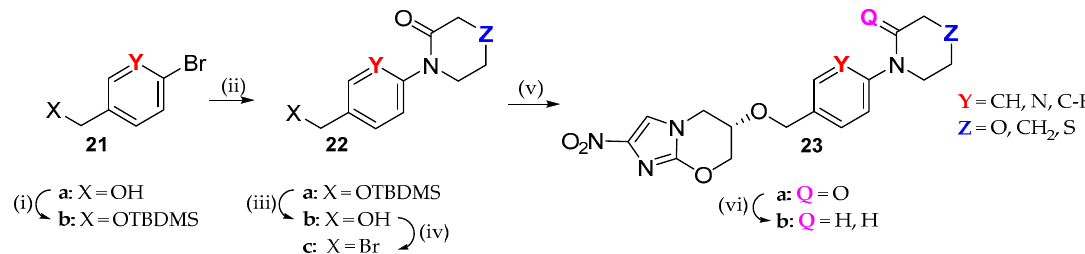
Figure 9. Hybrid analogue ( 20 ) of pretomanid ( 2 ) and linezolid. Molecules 2020 , 25 , x FOR PEER